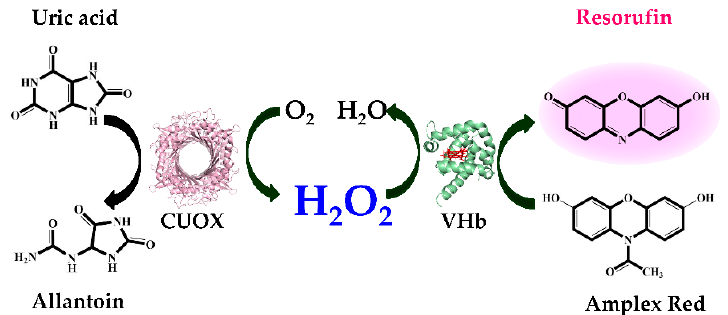
Figure 7. Schematic illustration of the colorimetric detection of uric acid using uricase and VHb (peroxidase)-catalyzed oxidation of Amplex Red.